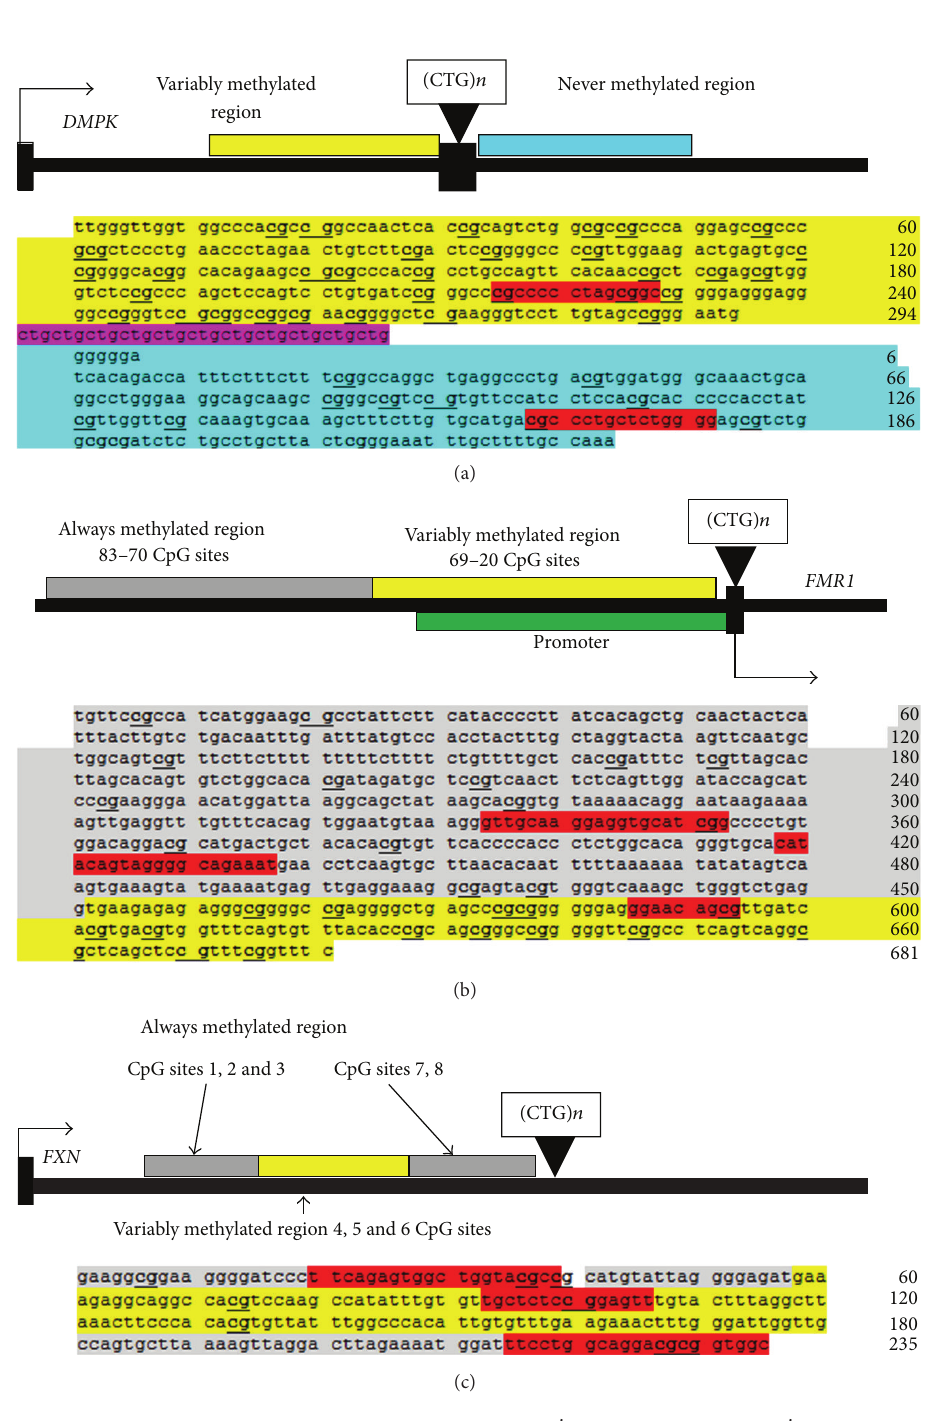
Figure 1: This figure shows the 3 gene regions under investigation: (a) DMPK 3 󸀠 UTR region, (b) FMR1 5 󸀠 UTR region, and (c) FXN intron 1 region . A scheme of the DNA sequence, transcriptional start site, and the regions analysed are shown. The grey shading shows the always methylated (AM) regions, blue shows the never methylated (NM), and the yellow area shows variably methylated (VM) regions. CpG sites are underlined and bold numbers at start and end of each line show base pair number in the sequence. A triangle shows the location of repeat expansion and the box above triangle shows the TNR repeats. The green highlighted region in the FMR1 gene indicates the promoter region. The CTCF binding sites are shown in